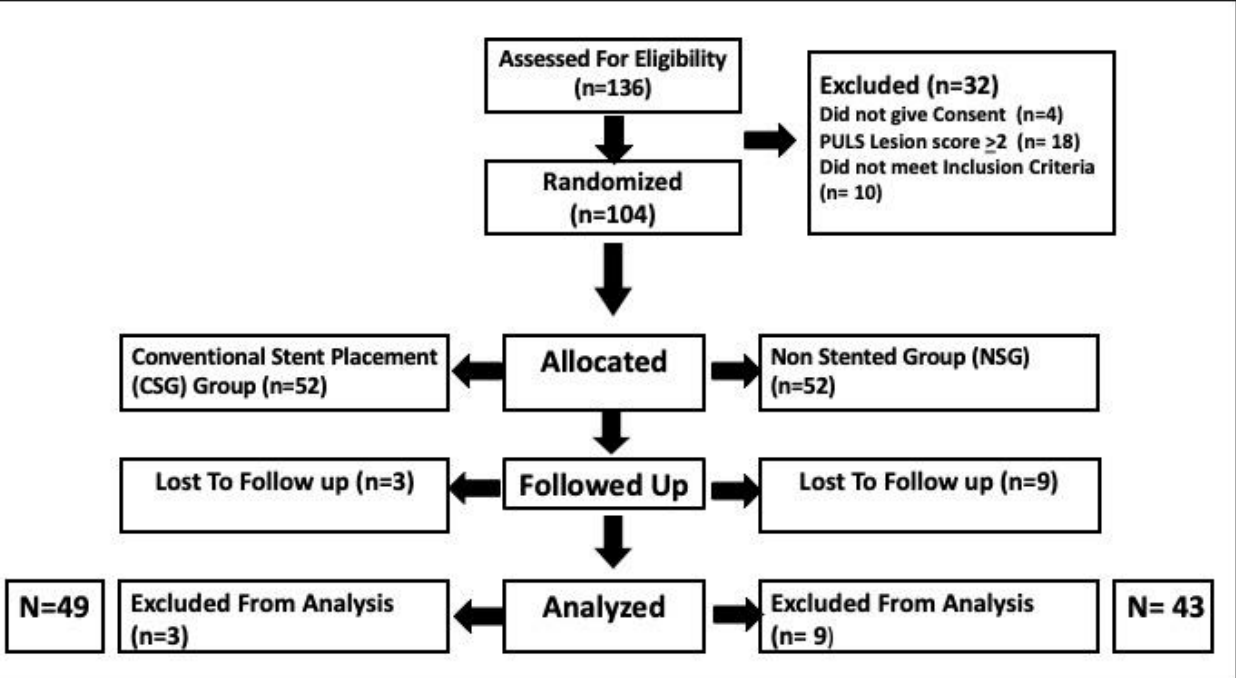
Figure 2. CONSORT diagram of our study.